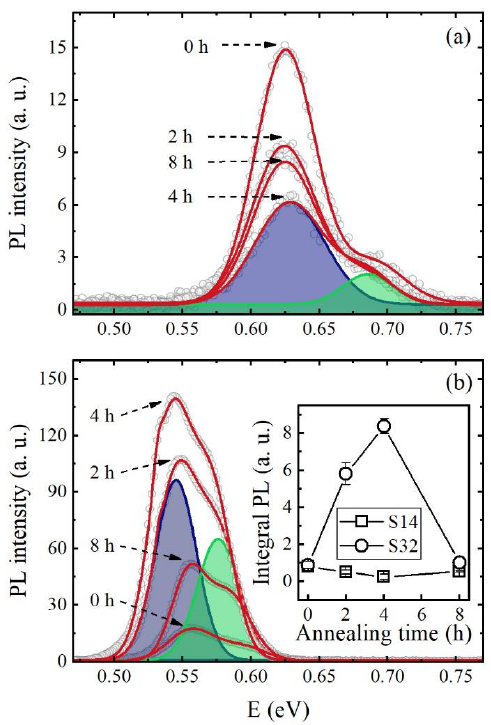
Figure 5. PL spectra of sample S14 ( a ), S32 ( b ) measured at 10 K before and after annealing. Inset shows the integrated PL as a function of annealing time. The behavior of the integrated PL is also of interest and shown in the insert of Figure. 5b. For example, for S32 the behavior of the integrated PL is very dramatic and can be understood by examining the separation between the peak energy for the L HH valley tran- sition and the HH valley transition, or ΔE = L HH − Г HH . Figure 6a shows the decrease of ΔE with annealing time owing to the compressive strain relaxation in the GeSn layer [22]. We observe t hat ΔE is significantly smaller by 27 ± 2 meV for sample S32 compared to S14 due to the higher Sn content. As a result, the PL from S32 has a larger direct bandgap compo- nent Г HH as compared to that of sample S14. This is expected due to the PL nonlinear de- pendence on ΔE resulting in more efficient light emission [23]. The increase of the Γ valley population is confirmed in Figure 6b, which shows that the peak height ratio Γ HH /L HH in- creases dramatically with decreasing ΔE. The increased emission from the Γ HH valley for sample S32 is also in good agreement with the enhanced integrated PL in Figure 5b.